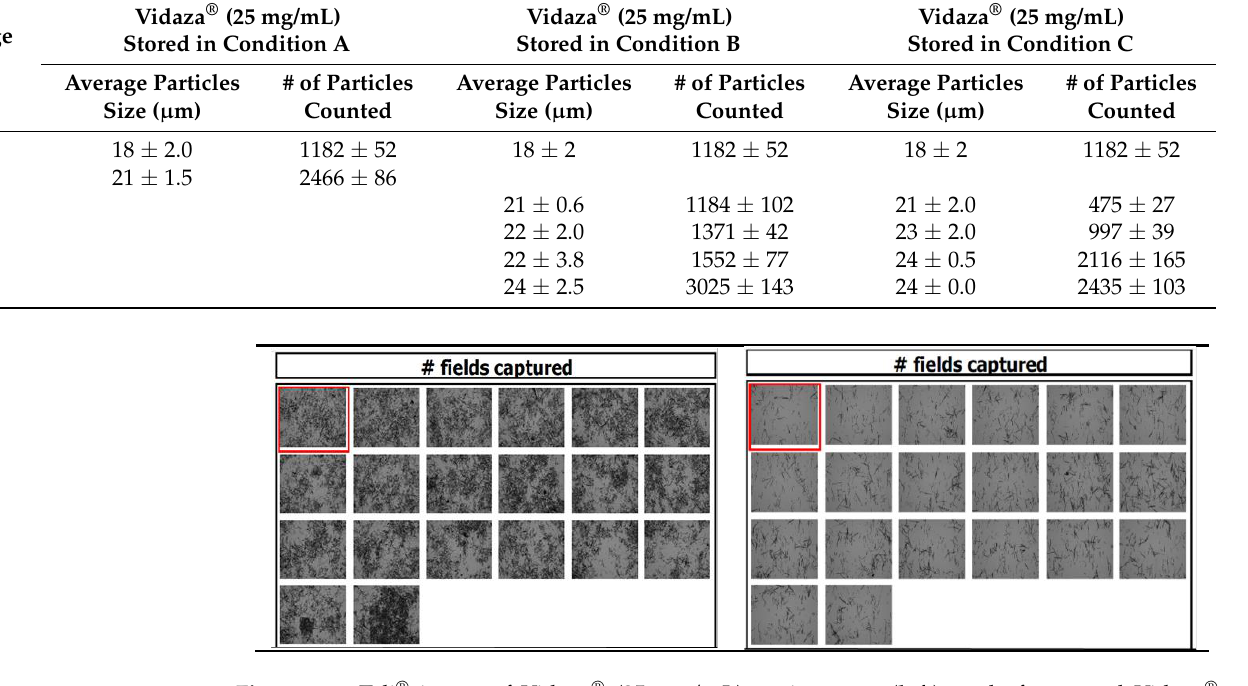
Figure 10. Tali ® image of Vidaza ® (25 mg/mL) at time zero ( left ), and after stored Vidaza ® (25 mg/mL) at 2 – 8 °C in a polypropylene syringe for up to 96 h ( right ).